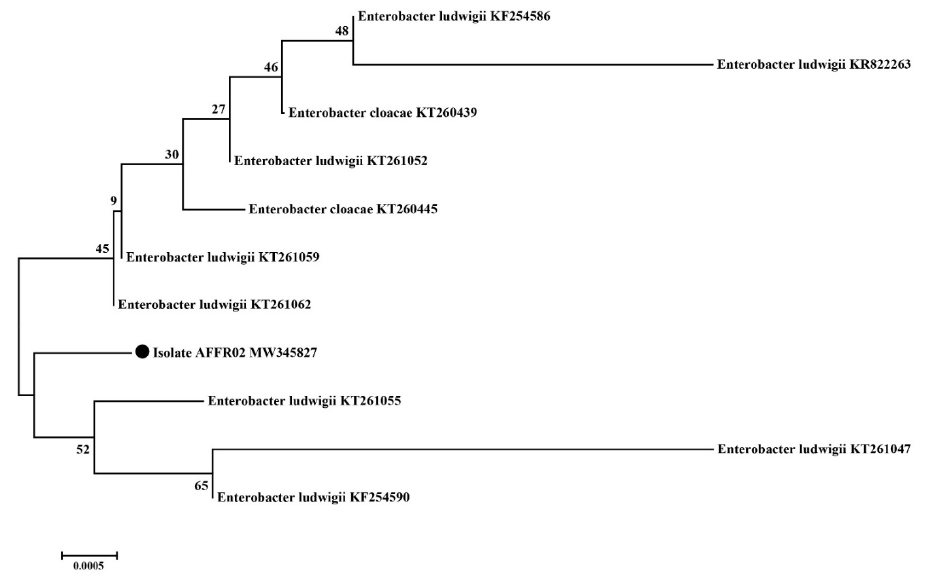
Figure 2. Identification of bacterial isolate AFFR02 using MEGA v.6. Phylogenetic analysis was performed by constructing neighbor-joining trees using a 16S rRNA gene sequence.